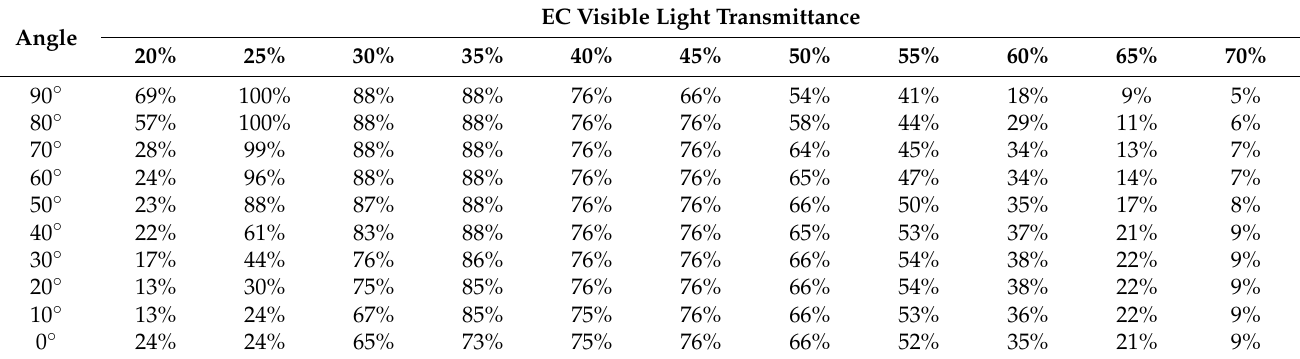
Table 9. Target illuminance achievement rates when the number of divisions of louvers is 15.